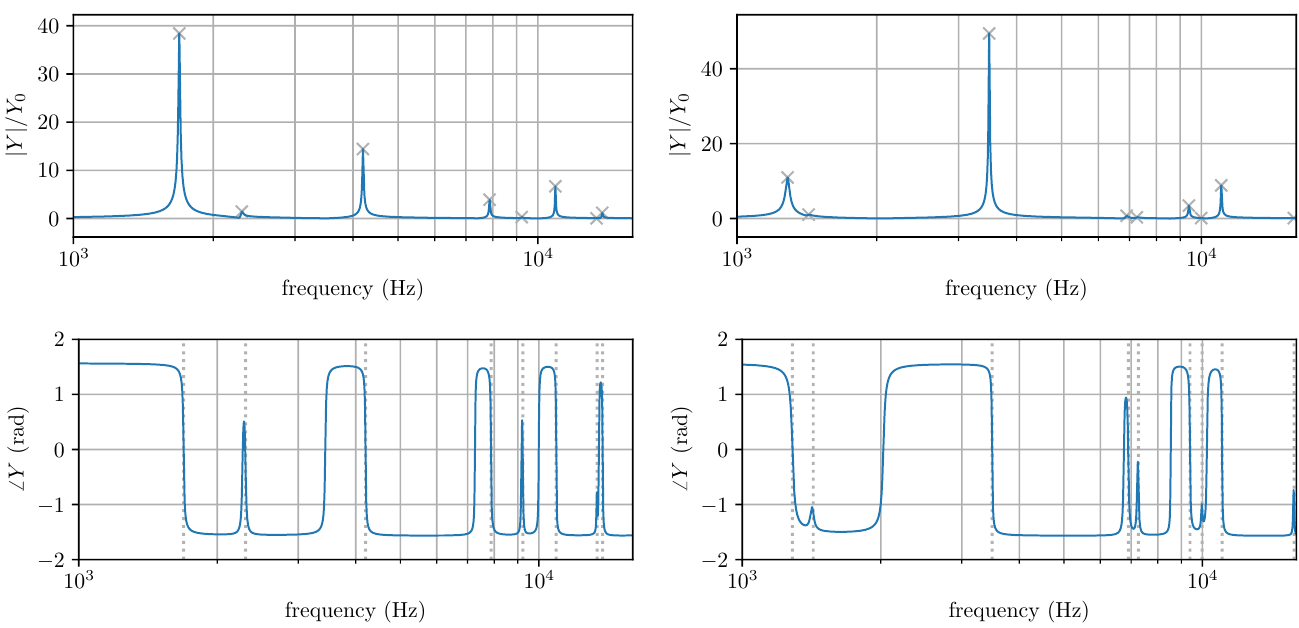
Figure 2. Normalised magnitude and phase of two example surface admittances ( left and right ) of two different slits within a QRM as a function of frequency in Hz, with identified resonances marked in grey dots. Y 0 = 1/ ρ 0 c 0 represents the admittance of